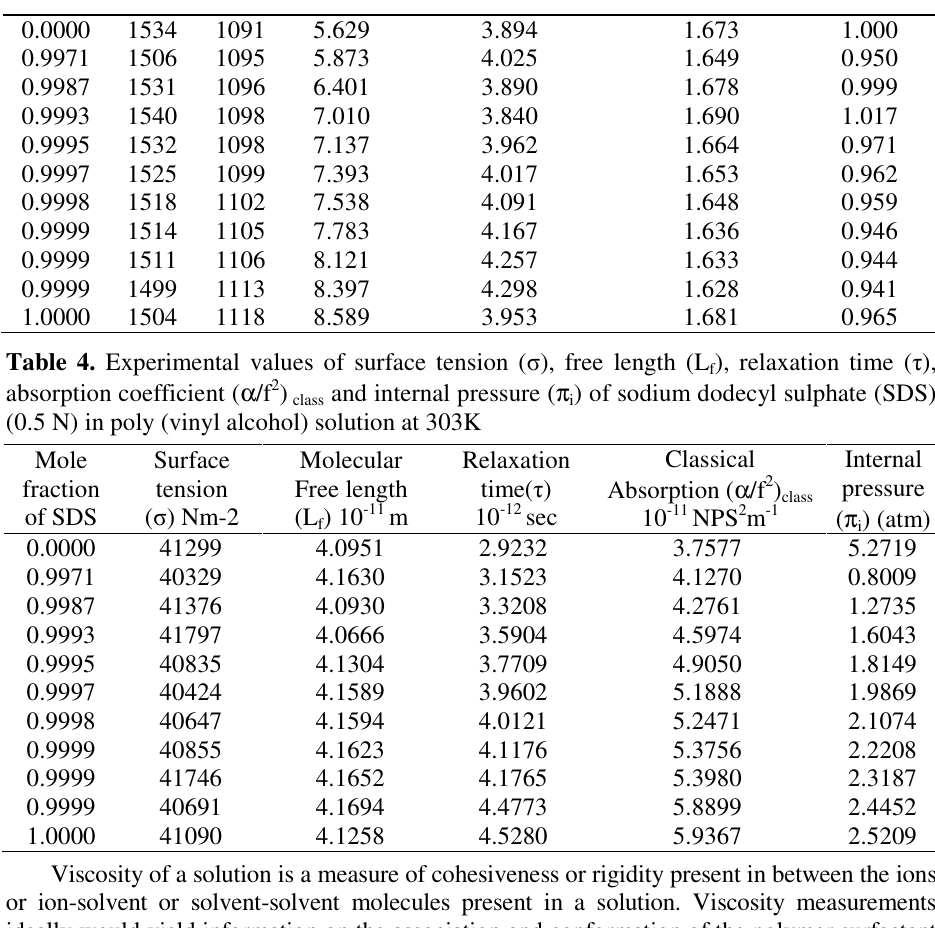
Table 3. Experimental values of ultrasonic velocity (U), density ( ρ ), viscosity ( η ), adiabatic compressibility ( β ), acoustic impedance (Z) and relative association (R ad dodecyl sulphate (SDS) (0.5 N) in poly (vinyl alcohol) solution at 303K